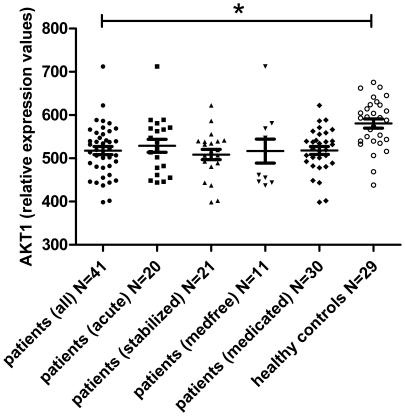
Scatter plots of PBMC AKT1 expression levels between patients, patient subgroups, and controls.Cross-lines show mean and standard error of the mean. * p<0.001 (independent samples t-test).